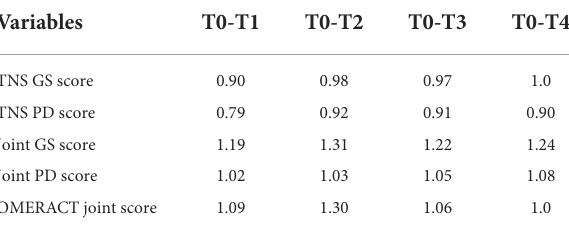
TABLE 4 Standardized response mean (SRM) of ultrasound lesion